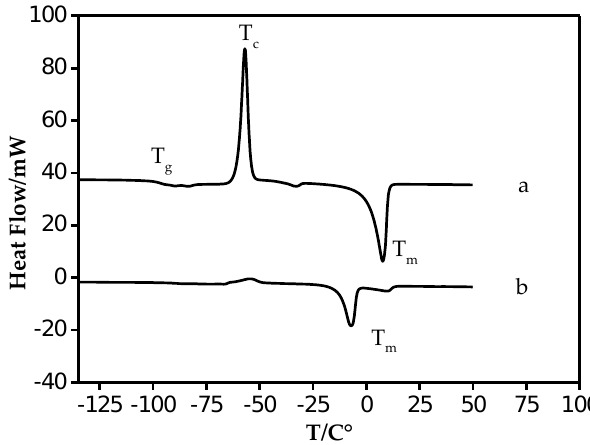
Figure 5. Differential scanning calorimetry (DSC) curves of [DEA][C7] ( a ) and [DBA][C6] ( b ) at heating rate of 10 °C.min −1 .